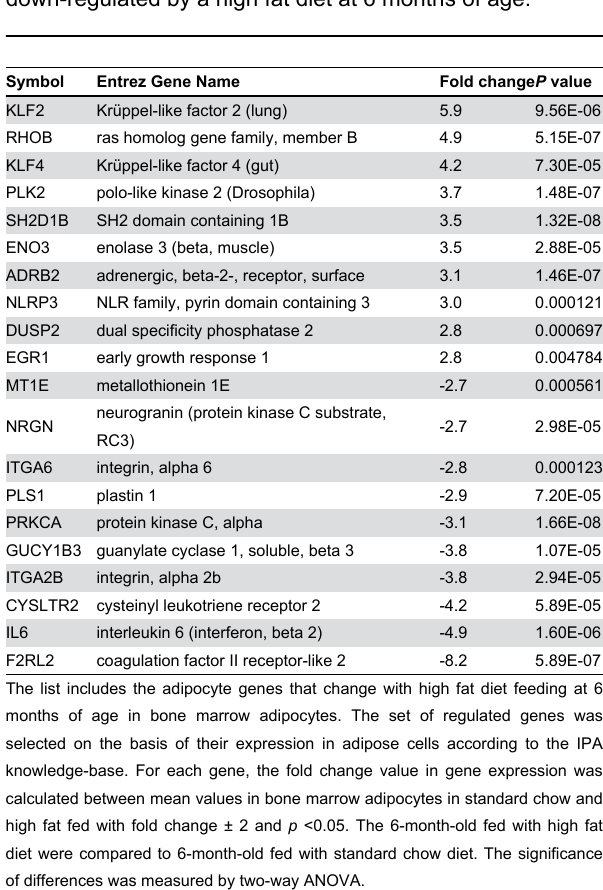
Table 5. Bone marrow adipocyte genes most highly up- and down-regulated by a high fat diet at 6 months of